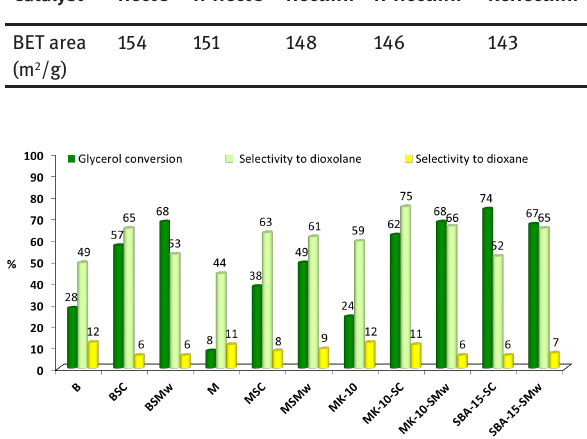
Figure 3: Catalytic activity results of the sulfonated catalysts.